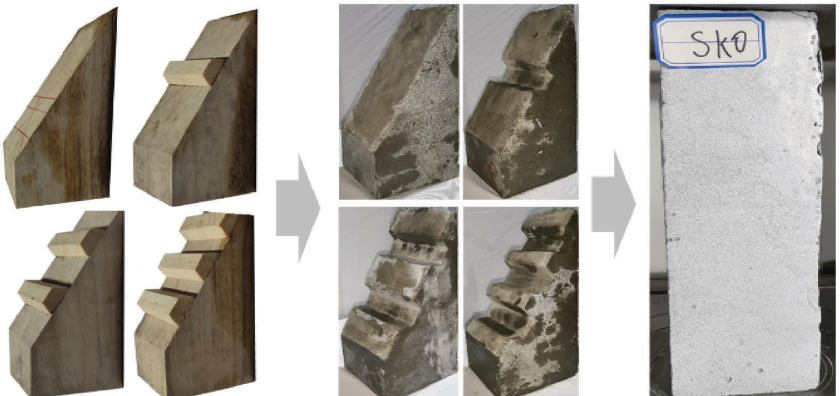
Figure 2: Te production process of the specimen. (a) Place-holding wooden block cutting. (b) UHPC casting forming. (c) NC casting forming.